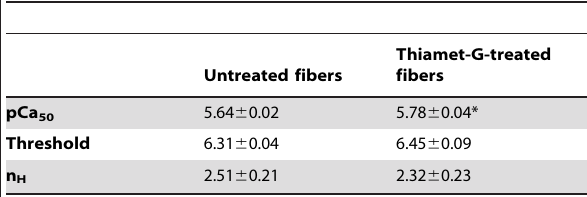
Table 2. Activation threshold, pCa 50 and Hill parameter values of skinned fibers isolated from untreated and Thiamet- G-treated